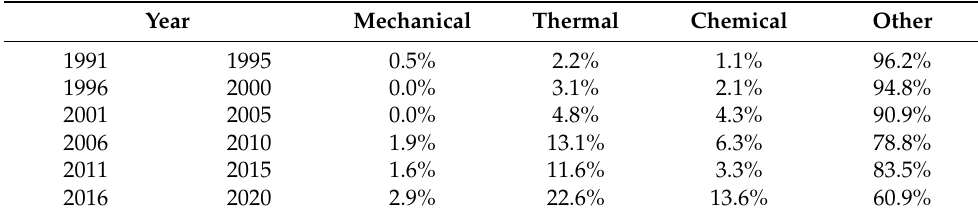
Table 7. Distribution of backward thermal recycling citations per type of patent cited.